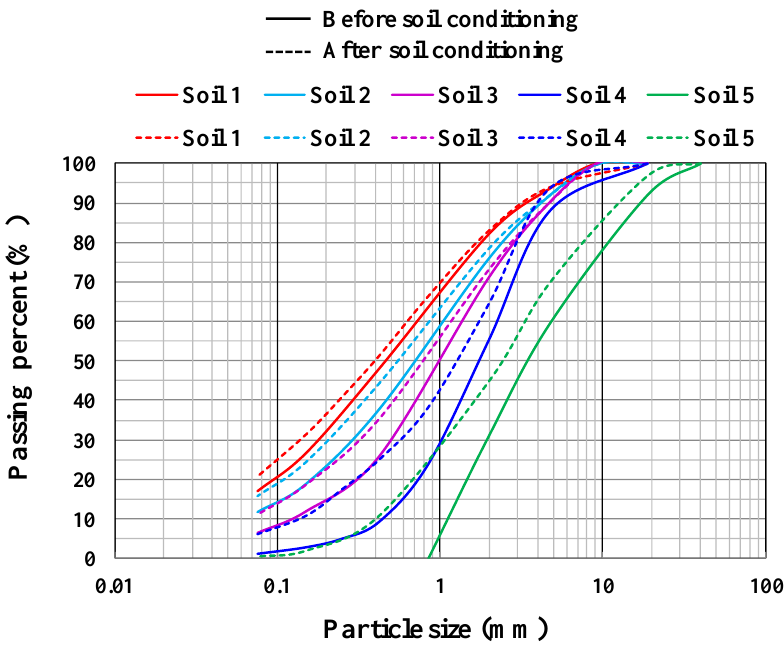
Figure 2. Particle-size gradation curves for the five weathered granite soils. Table 1. Physical properties of the five weathered granite soils.